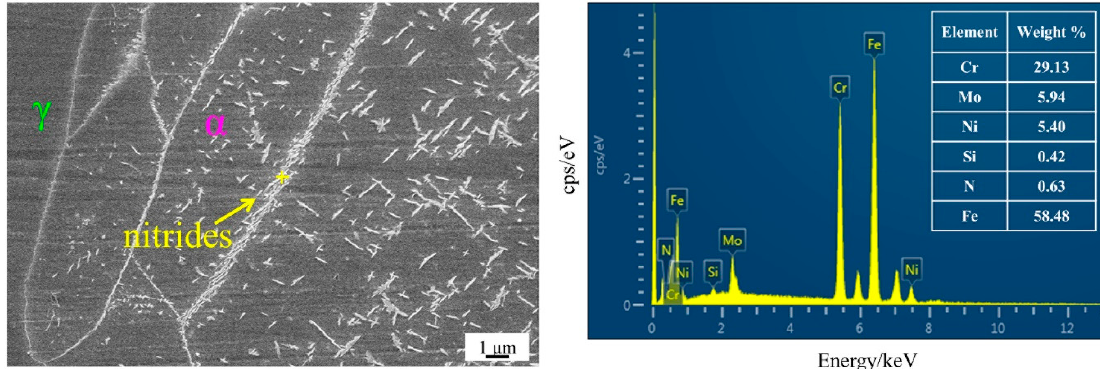
Figure 5. SEM-EDS analysis of specimen after solution treatment at 1200 °C.